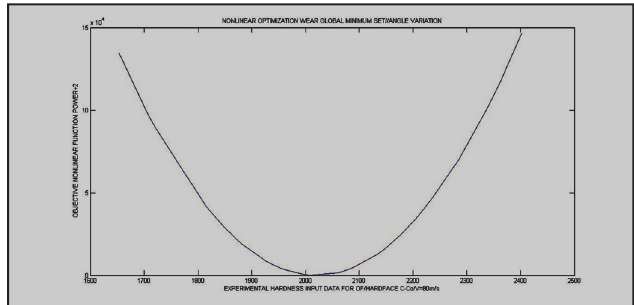
Fig. 9. Objective function (OF) nonlinear optimization results for Table 7 and Eq. (3) model, Matlab 2009-12. The impact velocity is 80 m/s. Results are acceptable with a Global Minimum sharply determined and running time is lower than a